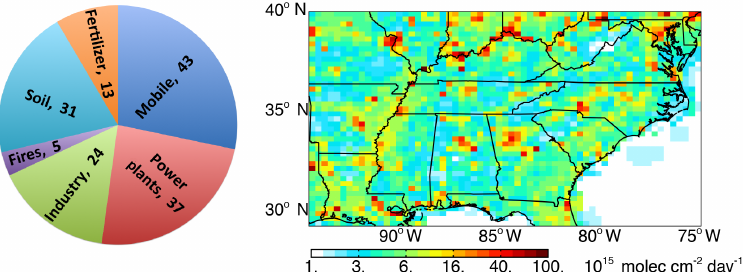
Figure 1. Surface NO x emissions in the Southeast US in GEOS-Chem for August and September 2013 including fuel combustion, soils, fertilizer use, and open fires (total emissions = 153GgN). Anthropogenic emissions from mobile sources and industry in the National Emis- sion Inventory (NEI11v1) for 2013 have been decreased by 60% to match atmospheric observations (see text). Lightning contributes an additional 25GgN to the free troposphere (not included in the figure). The emissions are mapped on the 0.25 ◦ × 0.3125 ◦ GEOS-Chem grid. The pie chart gives the sum of August–September 2013 emissions (GgN) over the Southeast US domain as shown on the map (94.5–75 ◦ W, 29.5–40 ◦